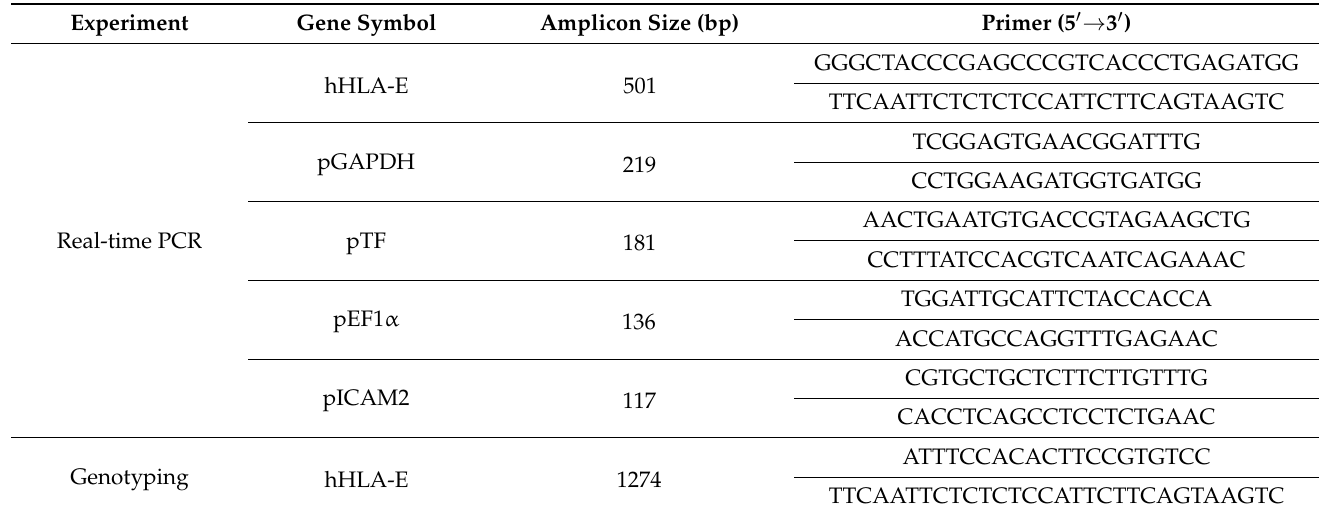
Table 1. Primers used in this